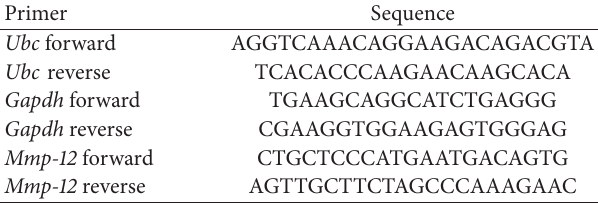
Table 1: Primer sequences used for gene expression analysis. Primer